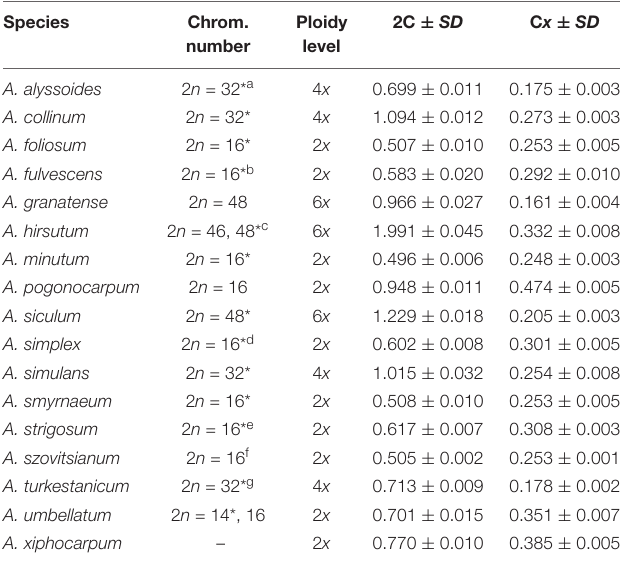
TABLE 2 | Chromosome numbers, ploidy level data and relative genome size values of the studied Alyssum species. Species Chrom. Ploidy number